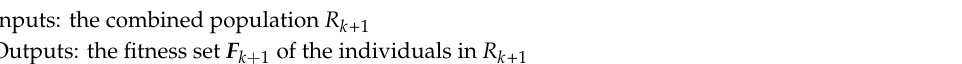
Algorithm 2 Fitness evaluation for the combined